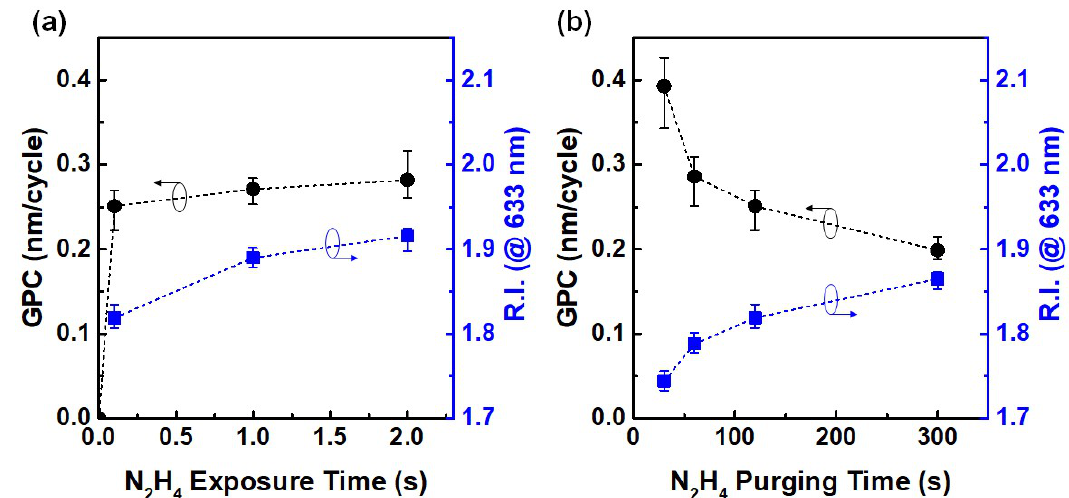
Figure 3. Saturation curves for the growth-per-cycle (GPC) for ( a ) hydrazine pulse and ( b ) purge time. The ALD process was performed at a substrate temperature of 300 °C. The refractive index (R.I.) at 633 nm of the deposited films was measured using spectroscopic ellipsometer after deposition.